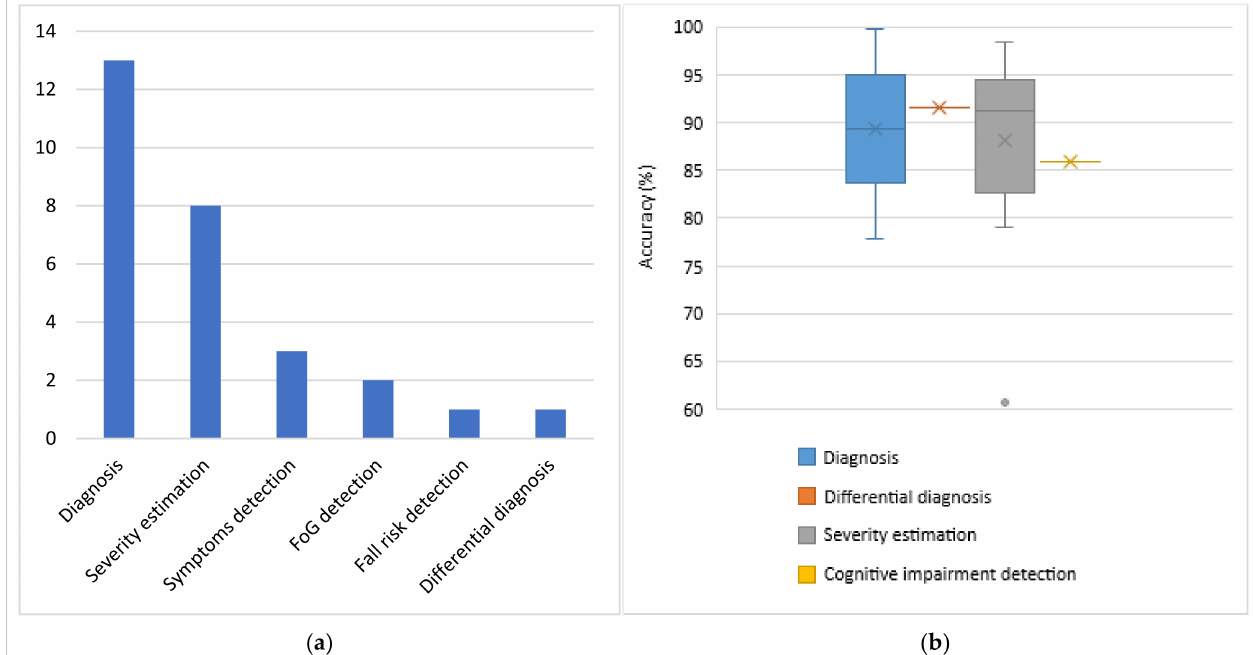
Figure 8. PD problems addressed based on data collected via a combination of various types of sensors and the respective obtained accuracies. ( a ) Number of studies per task; ( b ) accuracies obtained from the proposed models for each category of addressed tasks. Number of studies considered in this boxplot per task: n = 9 for diagnosis, n = 1 for differential diagnosis, n = 5 for severity estimation and n = 1 for cognitive impairment